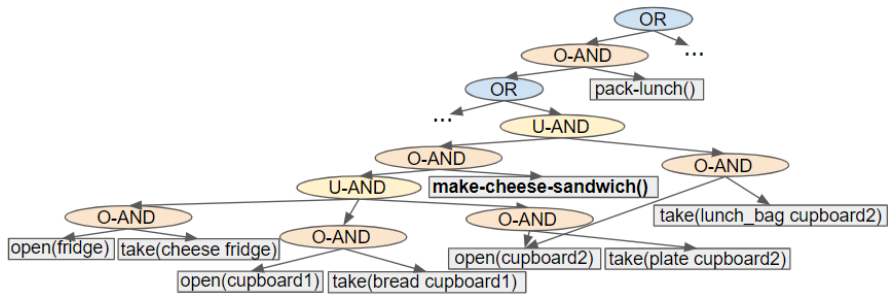
Figure 5. Example of an Action Graph. Arrows point towards the child node. O-AND stands for ORDERED-AND and U-AND is UNORDERED-AND . Figure only show a small sub-set of the actions in the complete kitchen domain Action